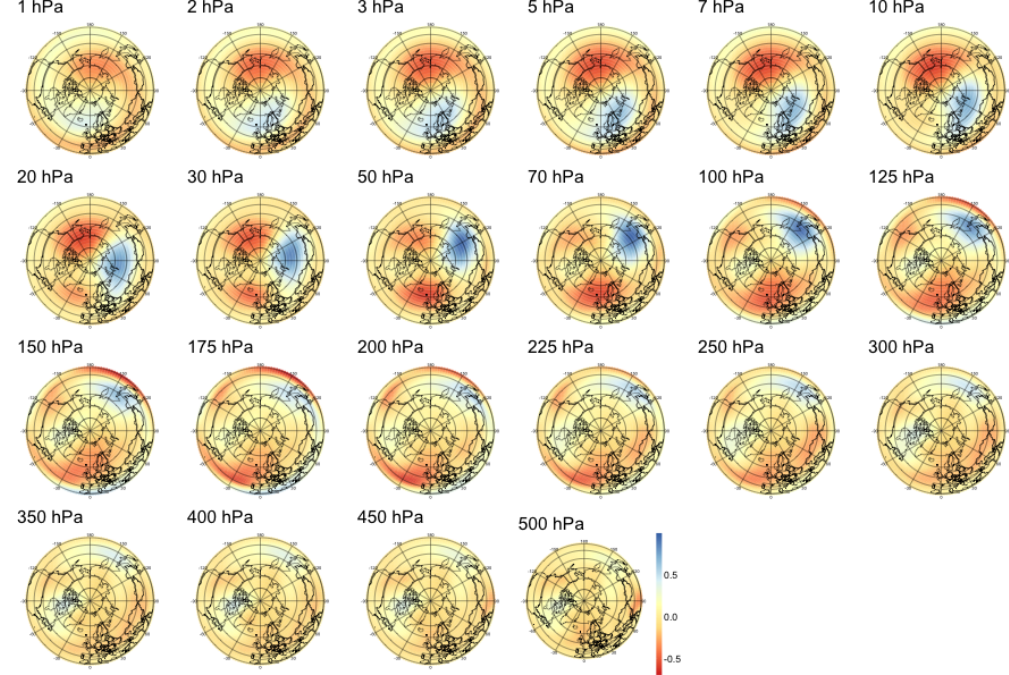
Figure B7. Pattern of PV waves maximizing correlation with the SSW index at a lead time of 14d.